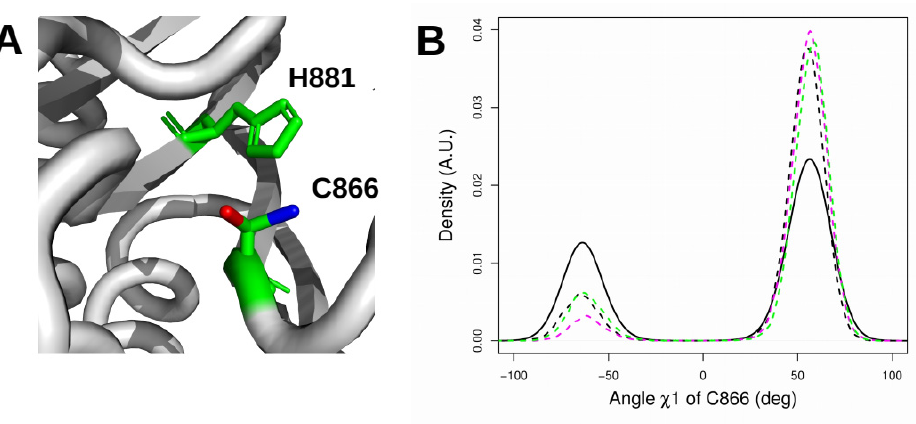
Figure 8. ( A ) Active (red) and resting (blue) orientations of C866 in the PDB structure 1HQ0. ( B ) Distribution of the dihe- dral angle χ 1 (N-C α -C β -S γ ) (°) of C866 for various values of the X-Pro peptidic angle ω (°) for P768 and P968 along MD trajectories. The solid and dashed curves correspond to the trajectories with cis and trans X-Pro imide bonds, respectively. In the MD simulations the active orientation appears with a dehydral angle value of 60° (40.6° in the crystal structure. The dashed curves are colored according to the trans isomers of prolines: trans -P768 (magenta), trans -P968 (green), and both trans (black).